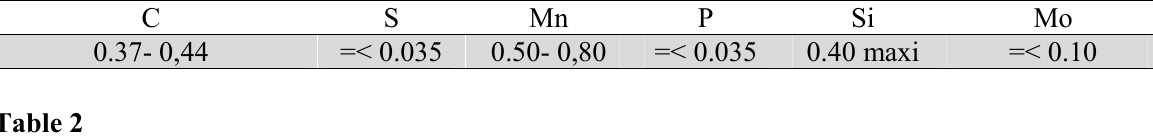
Chemical composition of AISI 1040 steel on % C S